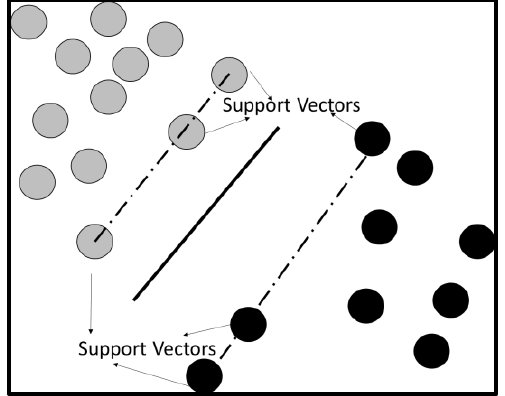
Figure 1. Principle of support vector machine.